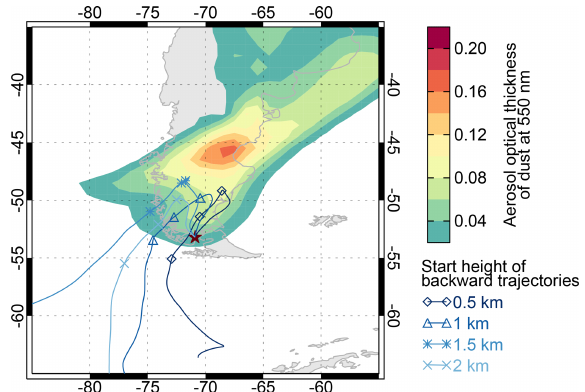
Figure 9. HYSPLIT 96h backward trajectories for heights of 0.5, 1, 1.5 and 2km for Punta Arenas on 17 February 2010, 03:00UTC, and modelled dust surface concentrations from the NAAPS aerosol model on 17 February 2010,